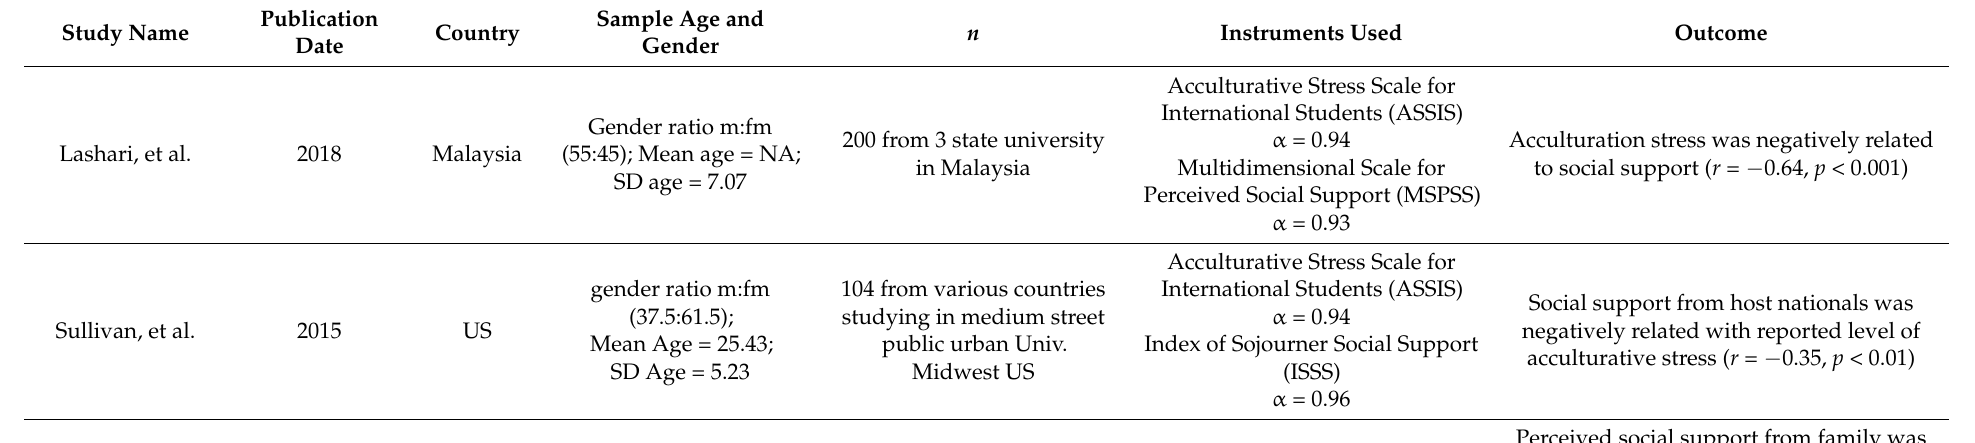
Table 1. Description of study characteristics in the meta-analysis